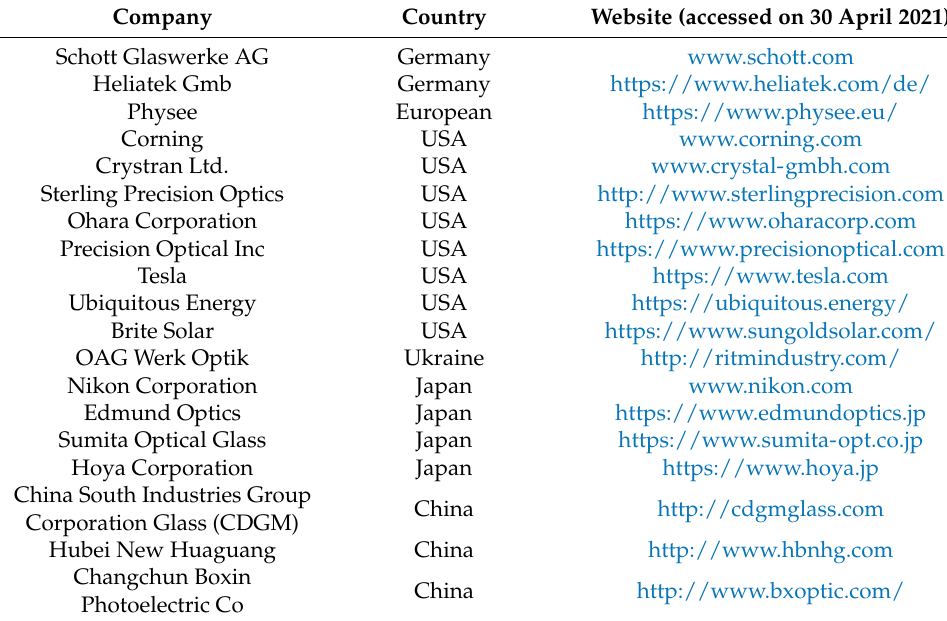
Table 5. Leading key players of the global high-tech glass market.